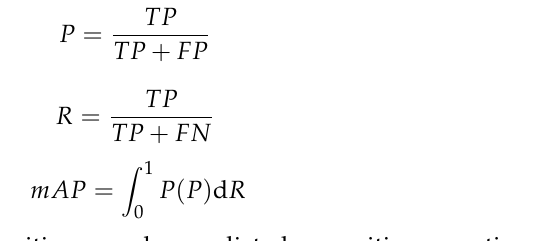
Table 6. Results of SR modified yolov5 in MSAR dataset.